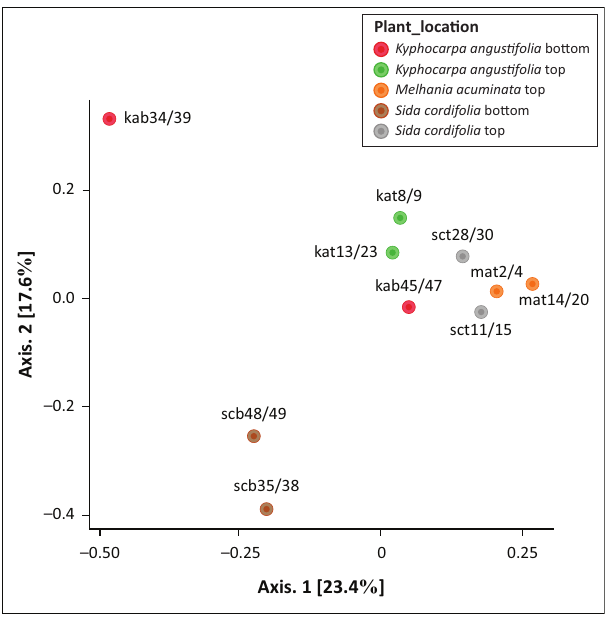
FIG URE 3: Taxonomic